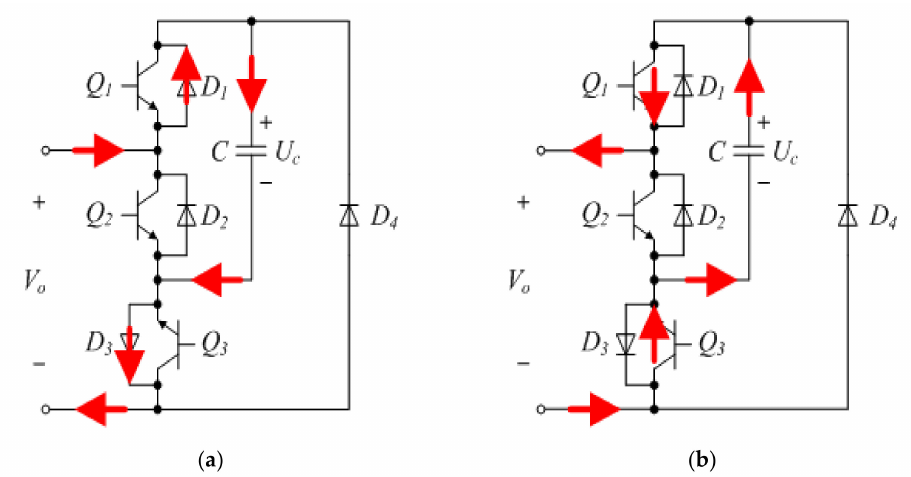
Figure 2. Current path of CSSM in case that submodule is connected to the converter in normal operation mode: ( a ) capacitor charging; ( b ) capacitor discharging.